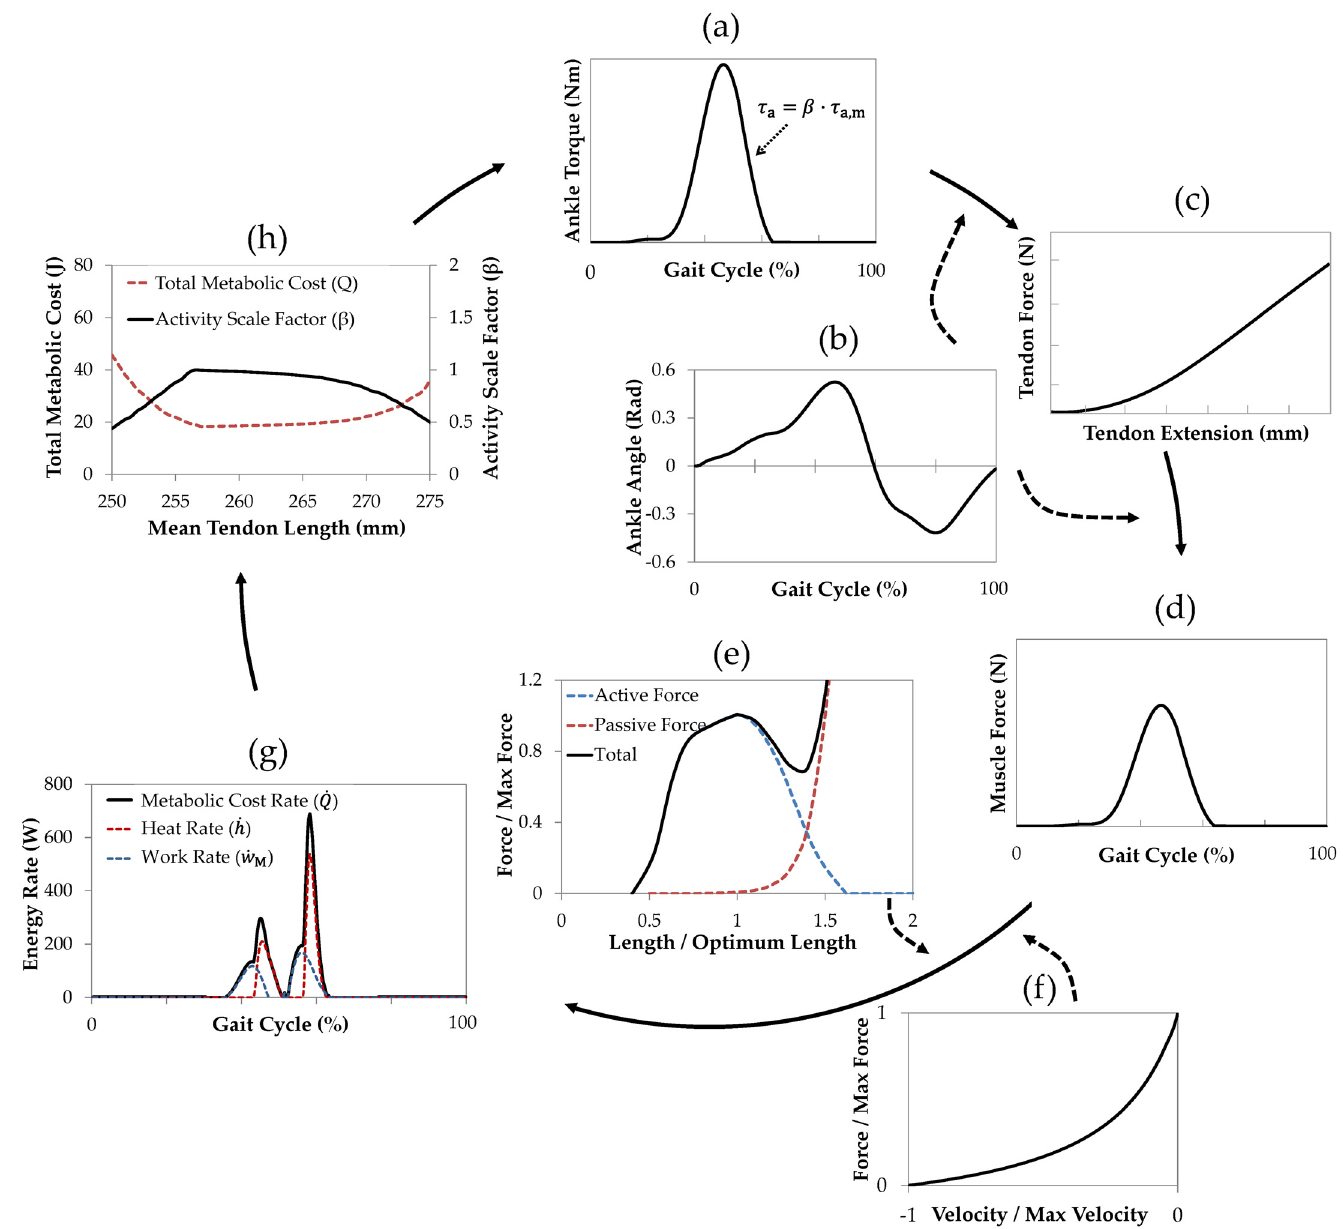
Fig 6. Musculotendon operation. a) ankle torque over a gait cycle, b) ankle angle over a gait cycle, c) force-extension response of tendon from our discrete tendon model, d) required muscle force to produce the ankle torques in part (a), e) muscle length-force relation, f) muscle force-velocity relation, g) metabolic cost rate as a combination of generated muscle heat and mechanical work, h) ankle torque adjustment according to the ratio of the current total metabolic cost to the minimum total metabolic cost for a range of mean tendon lengths and fiber length standard deviations (SDs). Total metabolic cost results in part (h) are plotted for mean tendon lengths between 250mm to 275mm and fiber length SD = 1.5